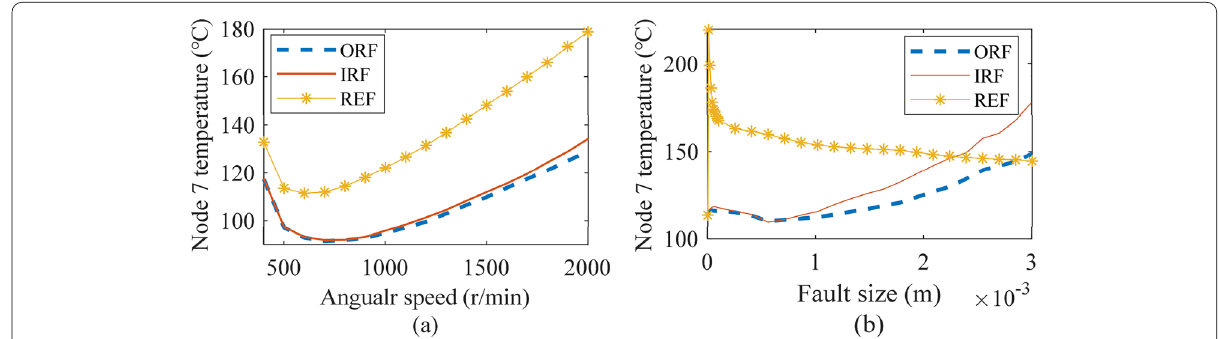
Figure 9 Change of temperature with different